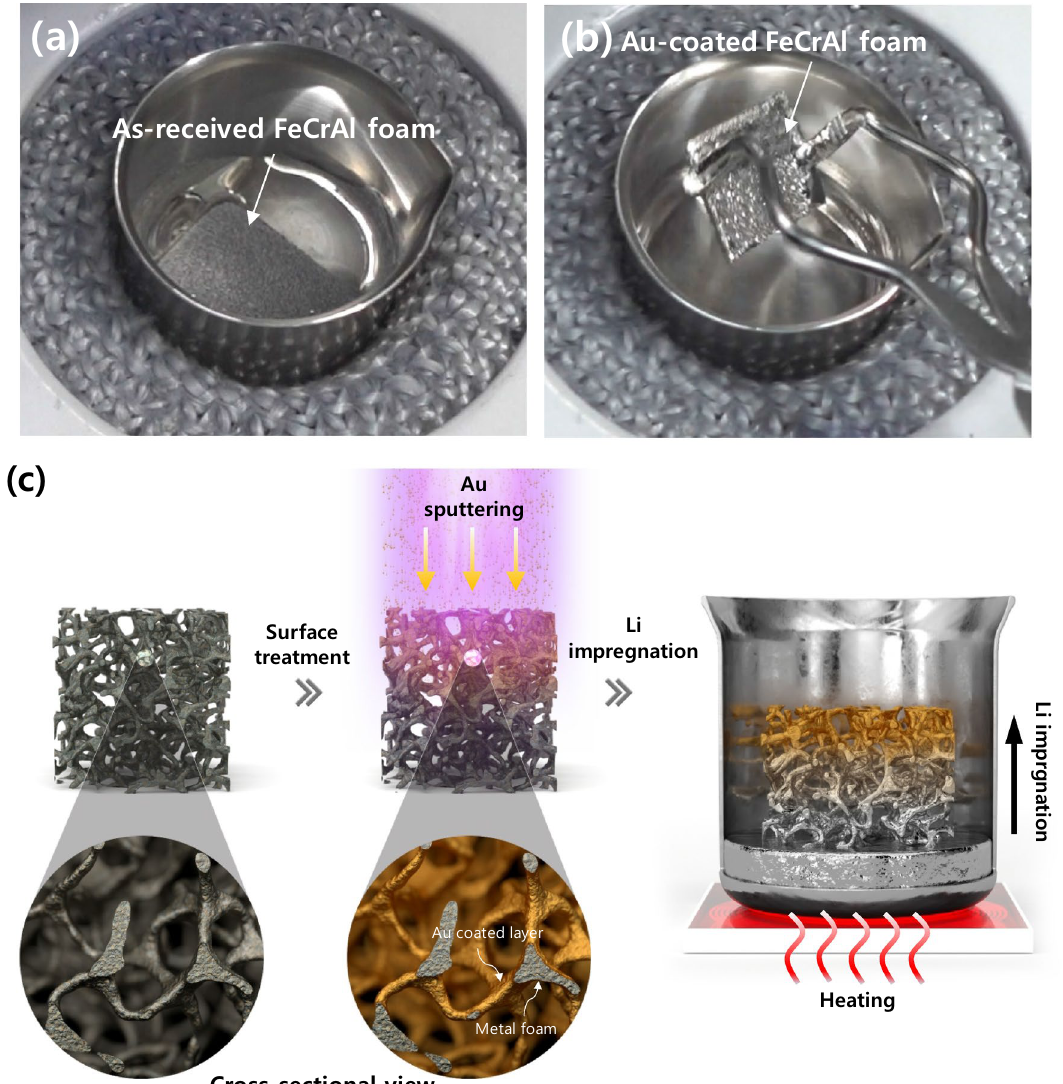
Figure 3. Lithium impregnation of ( a ) as-received FeCrAl foam ( b ) gold-coated FeCrAl foam, and ( c ) schematic of lithium impregnation after gold coating onto the FeCrAl